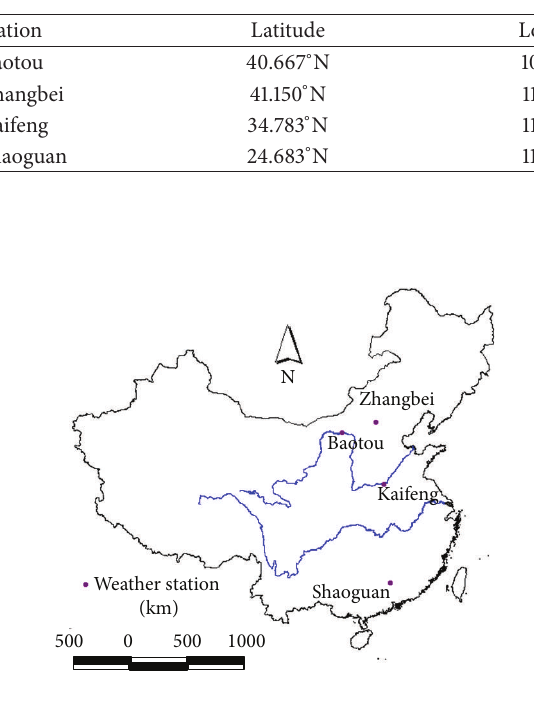
Figure 1: Locations of the weather stations used in this